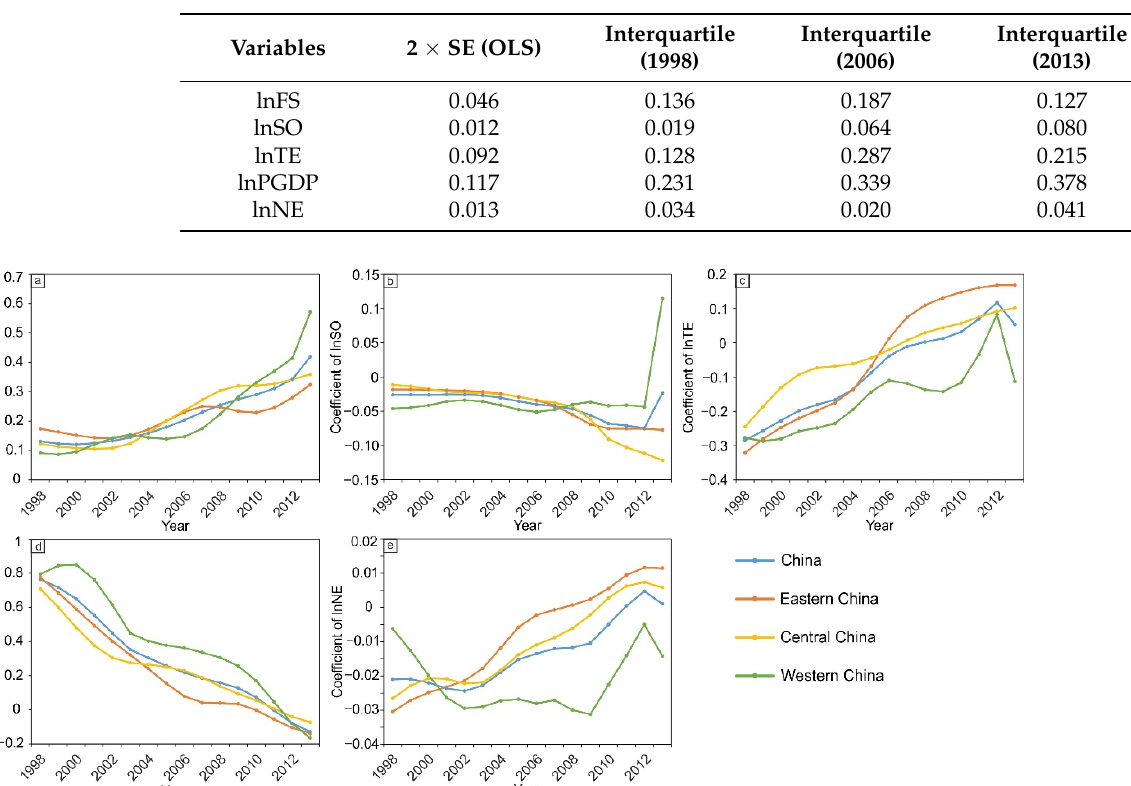
Table 4. Spatial non-stationarity tests of variables for year 1998, 2006 and 2013.